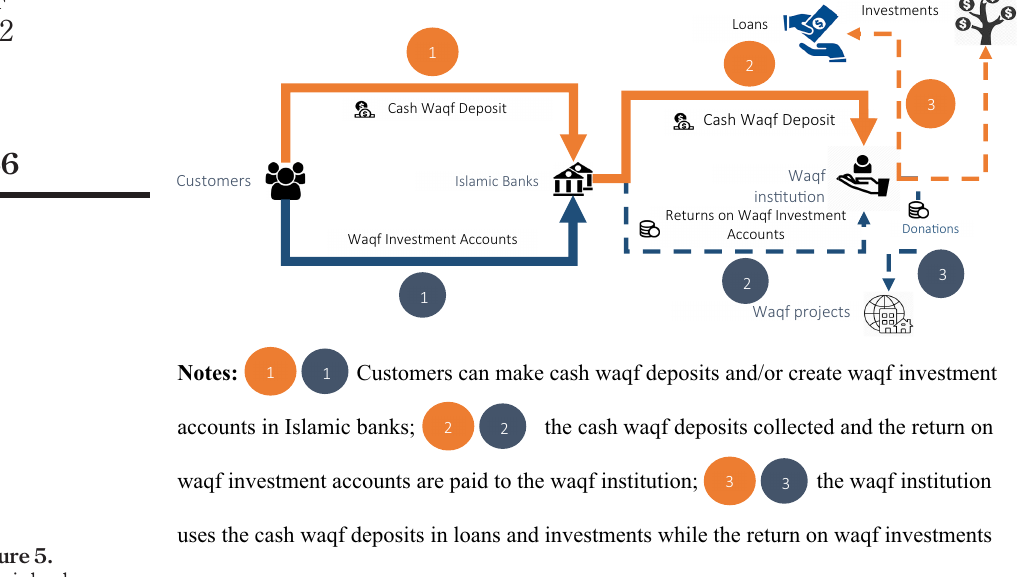
Figure 5. Islamic banks as a way to leverage funds for